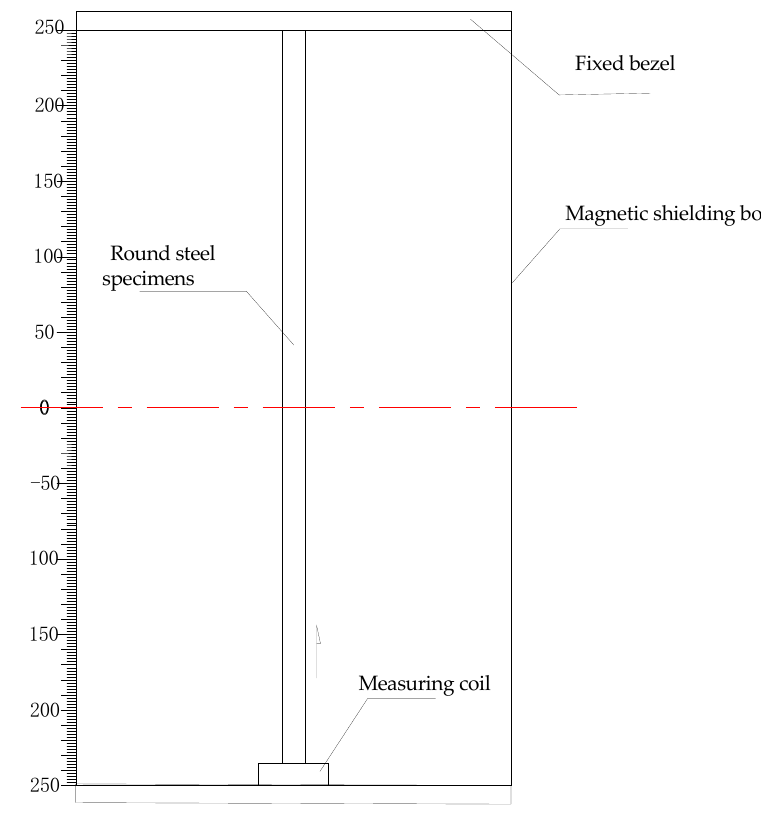
Figure 5. Magnetic flux measurement principle for steel specimens.